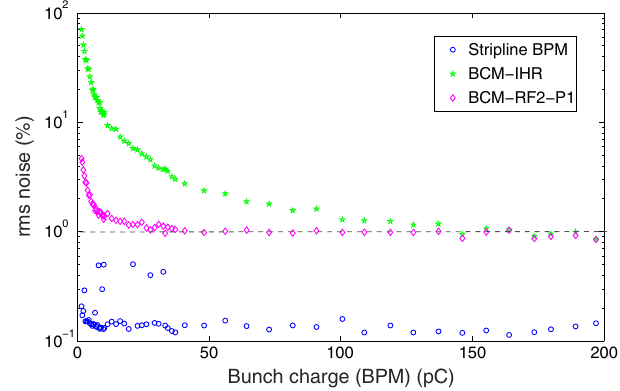
FIG. 41. Noise (rms) measurements of the standard ICT (green stars), Turbo-ICT-2 (first pulse shown, magenta diamonds) and a stripline BPM located close to the ICTs (blue circles), as a function of bunch charge (as measured with a